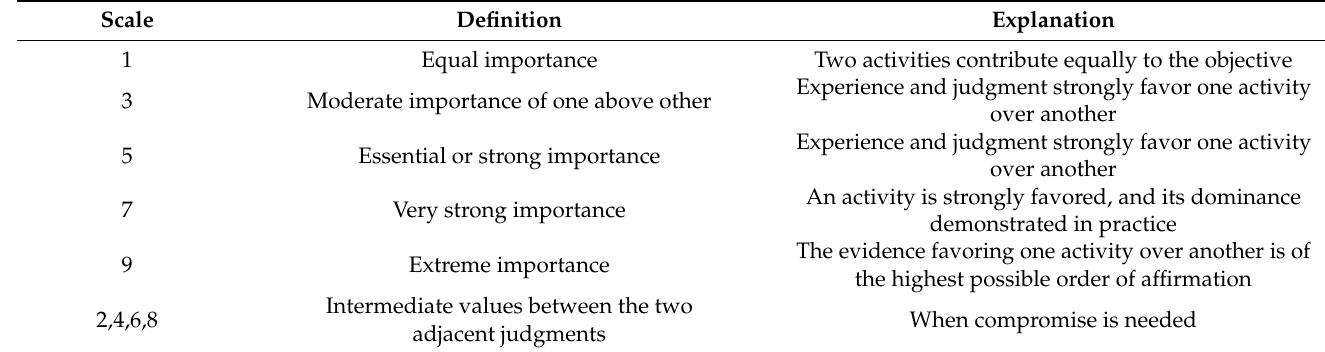
Table 1. Saaty’s scale of relative